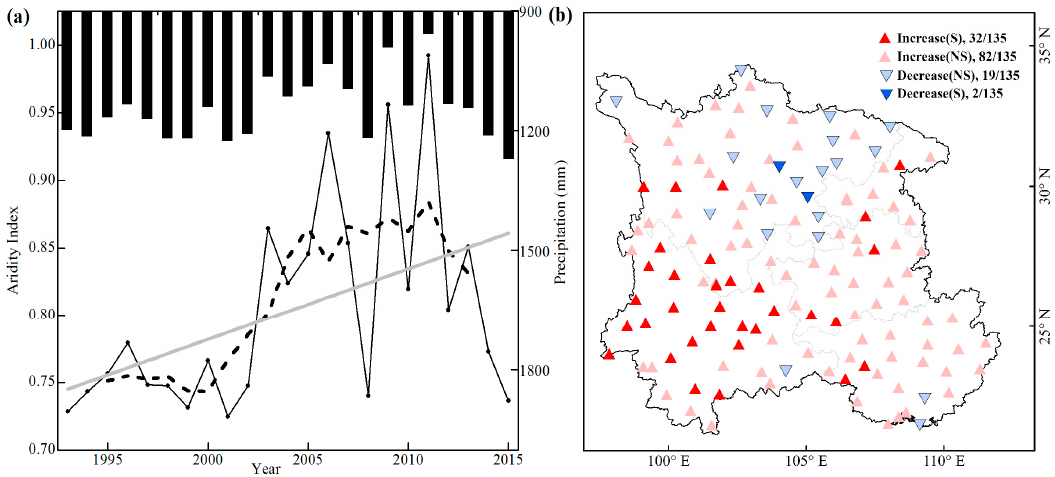
Figure 4. ( a ) Variation of aridity index in Southwest China from 1993 to 2015. The black dot line is the five-year moving average, the gray line is the linear trend fitted, and the bars are annual precipitation. ( b ) Spatial distribution of significance level in aridity index for the 135 meteorological stations. Red triangles indicates an increasing trend, while blue inverted triangles indicates decrease trend; S and NS in the legend indicate significant and insignificant at p = 0.05, respectively. The number after S or NS means the count of stations out of 135 stations in each category.